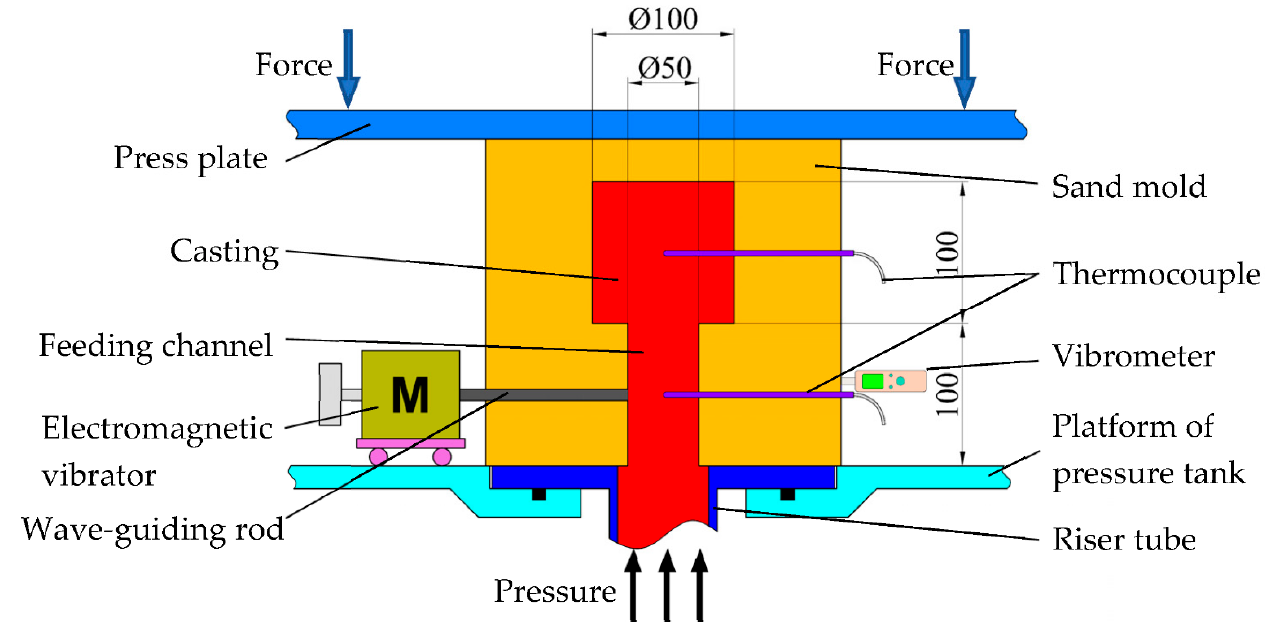
Figure 1. The LPSC setup with